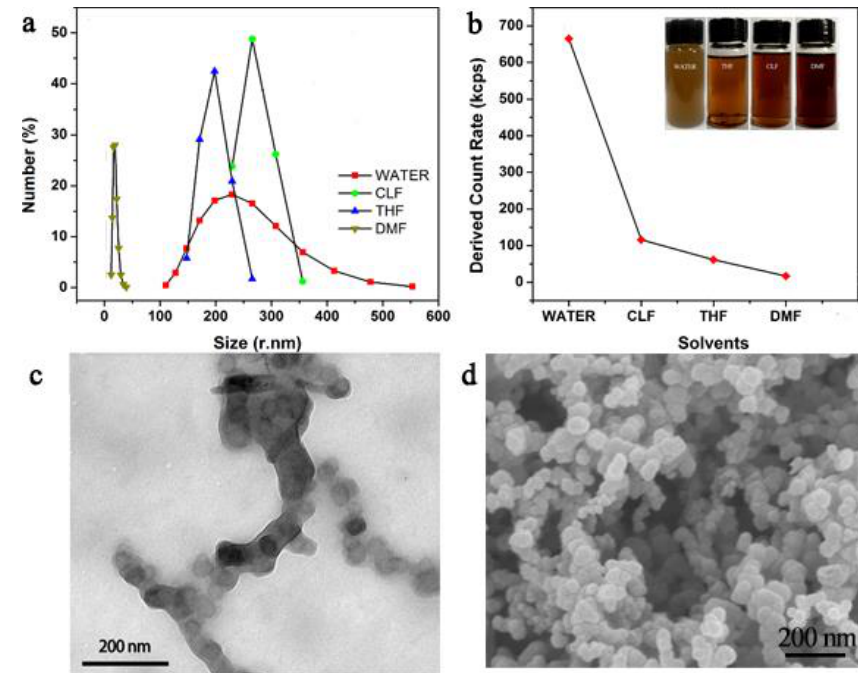
Figure 2. ( a ) The size distribution of PNVPY particles in different solvents. ( b ) The value of Derived Count Rate of PNVPY particles dispersed in different solvents (solution concentration = 0.81 g/L). The inset is the photos of PNVPY particles dispersed in different solvents. ( c ) Transmission electron microscope (TEM) photograph of PNVPY particles obtained from its N , N -dimethylformamide (DMF) dispersion. ( d ) Scanning electron microscope (SEM) photograph of CB particles obtained from its ethanol dispersion.